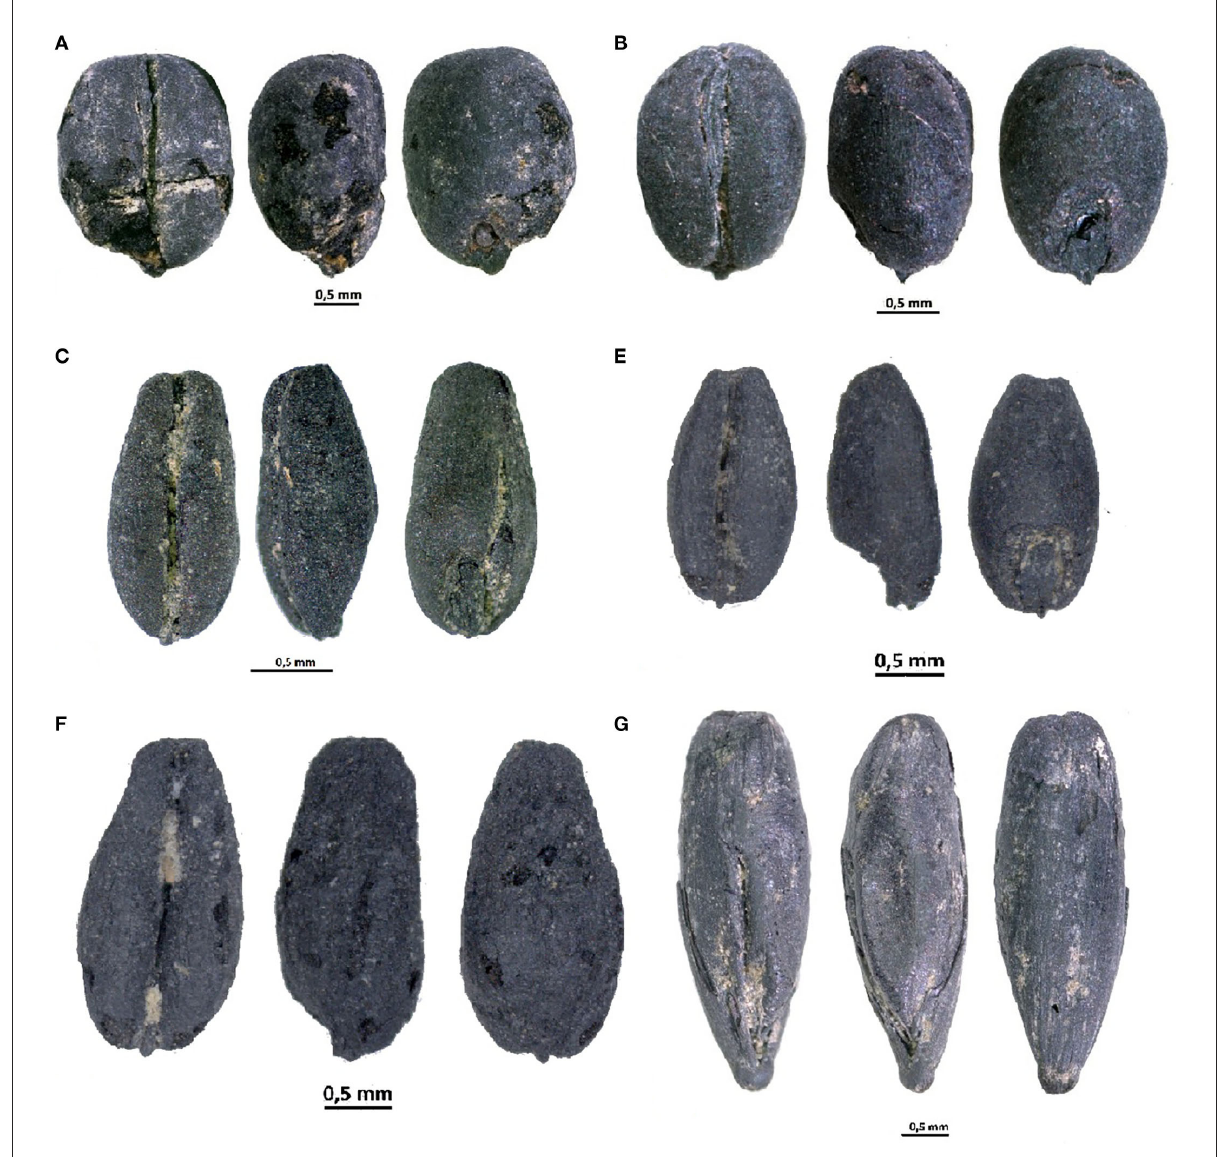
FIGURE6 Caryopses of Triticum aestivum (A,B) , Triticum sp. (cf. glume/ tetraploid wheat or T. carthlicum ) (C,E,F) , and Avena sp. (G)